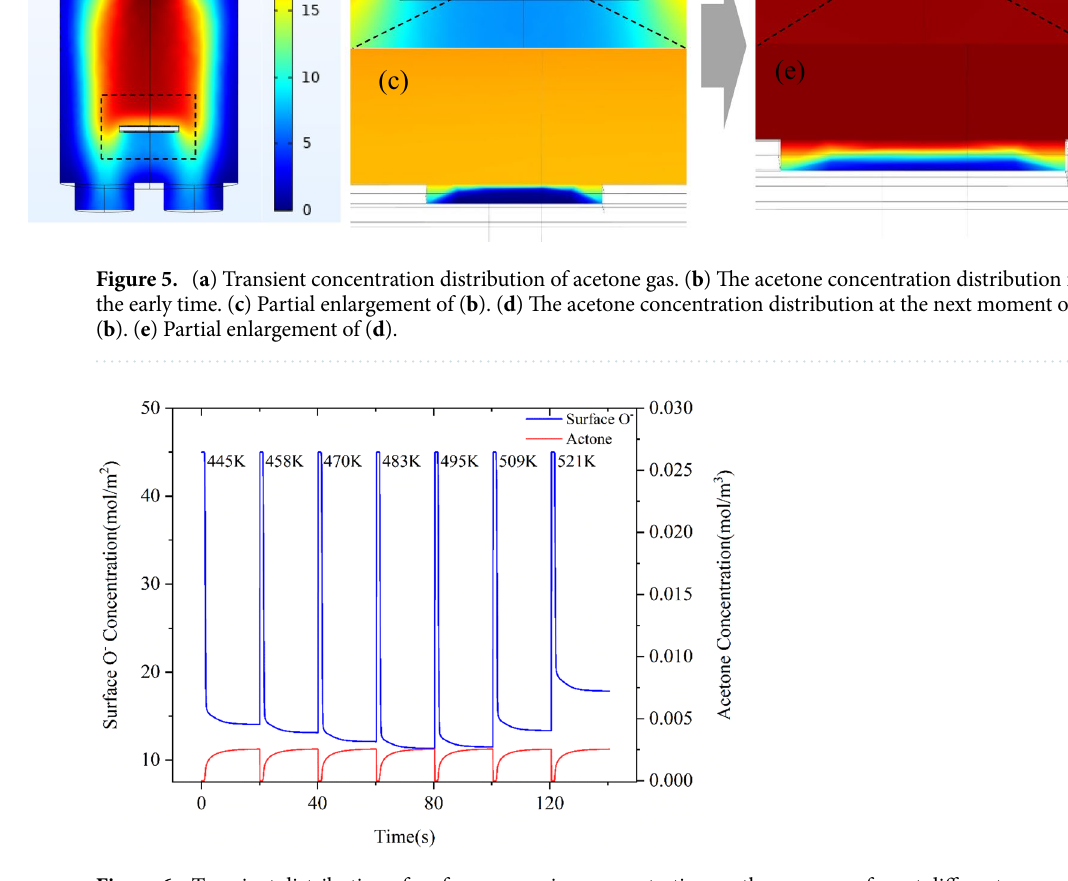
Figure 6. Transient distribution of surface oxygen ion concentration on the sensor surface at different temperatures, the blue line is the acetone concentration distribution inside the sensor under the action of diffusion and